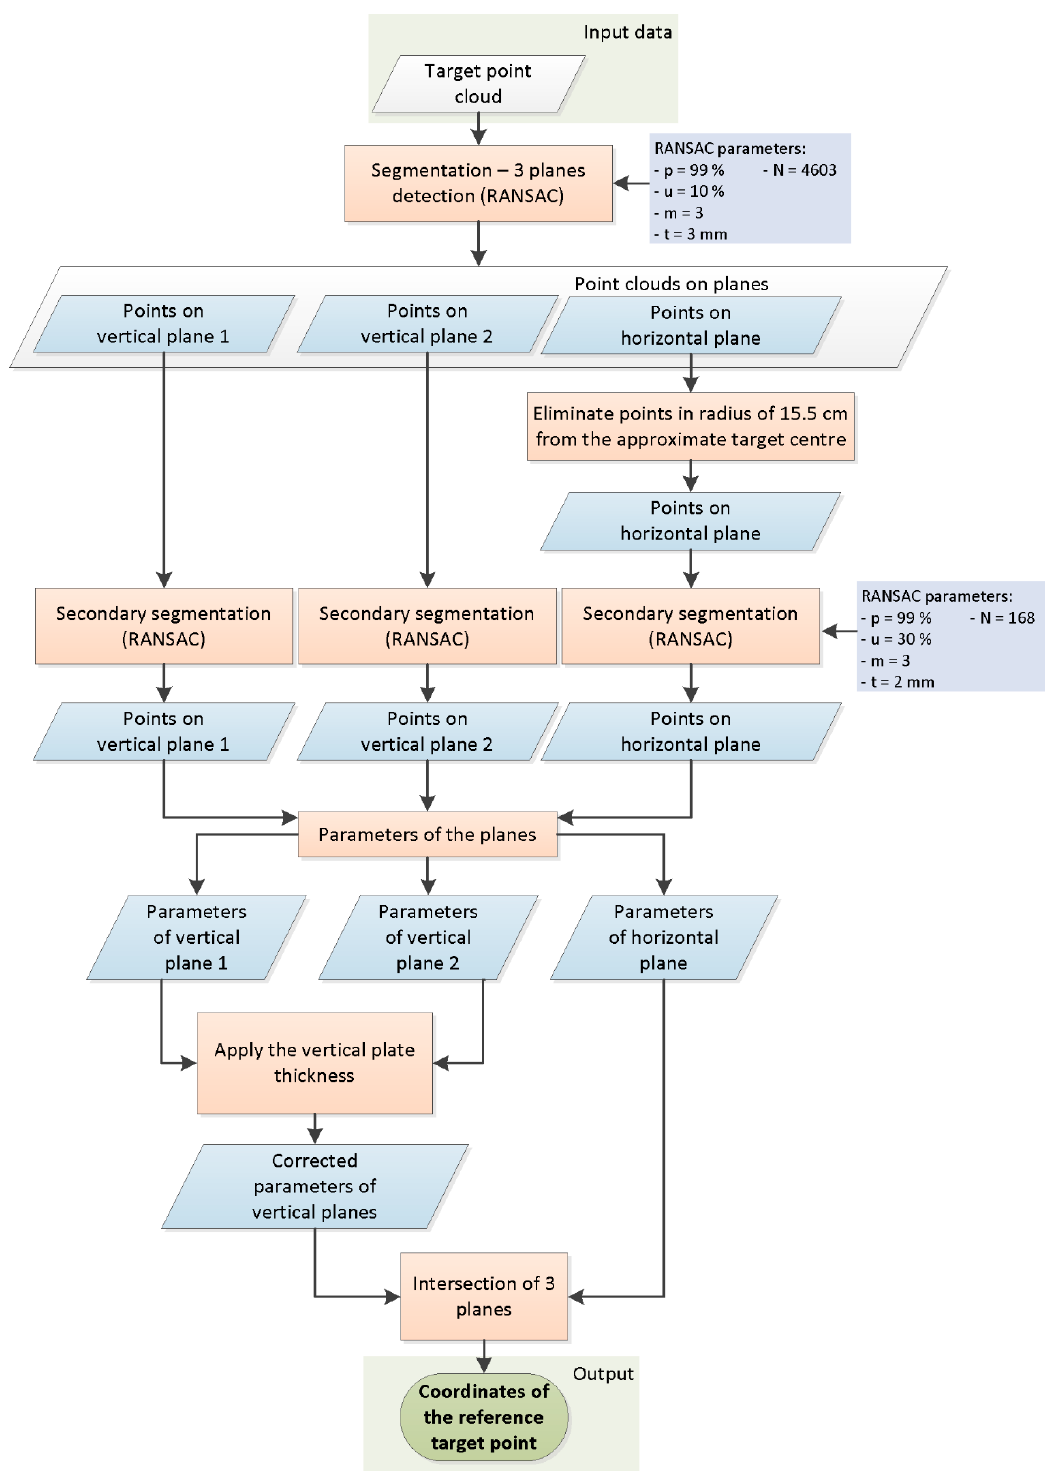
Figure 2. Diagram of algorithm used to define coordinates of reference point for new target.